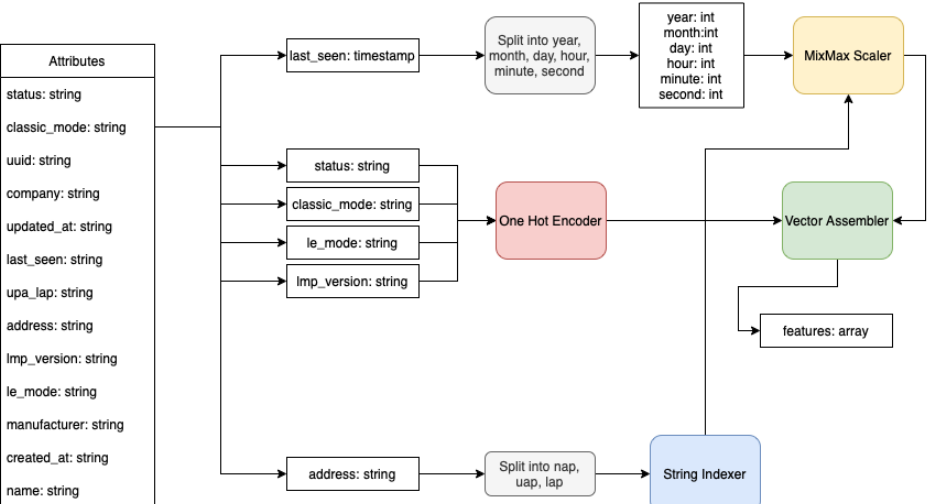
Figure 7. Preprocessing flow of Bluetooth device data.